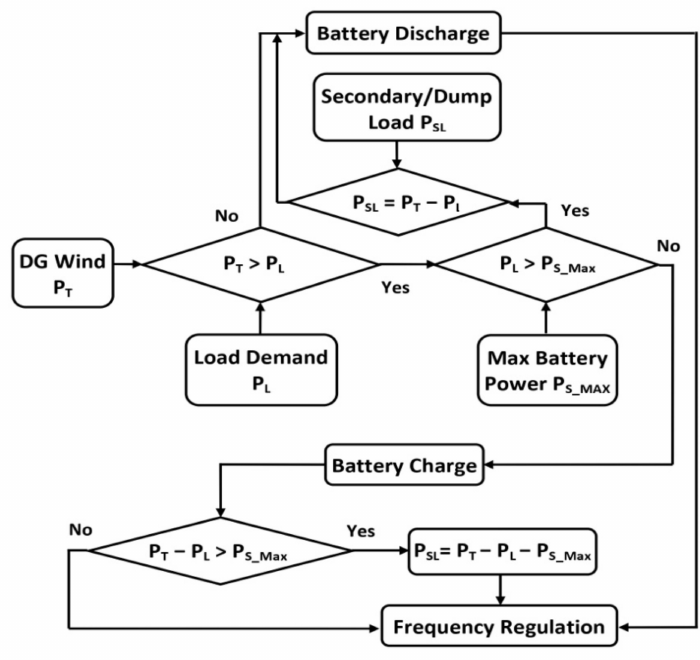
Figure 5. The control scheme of a synchronous